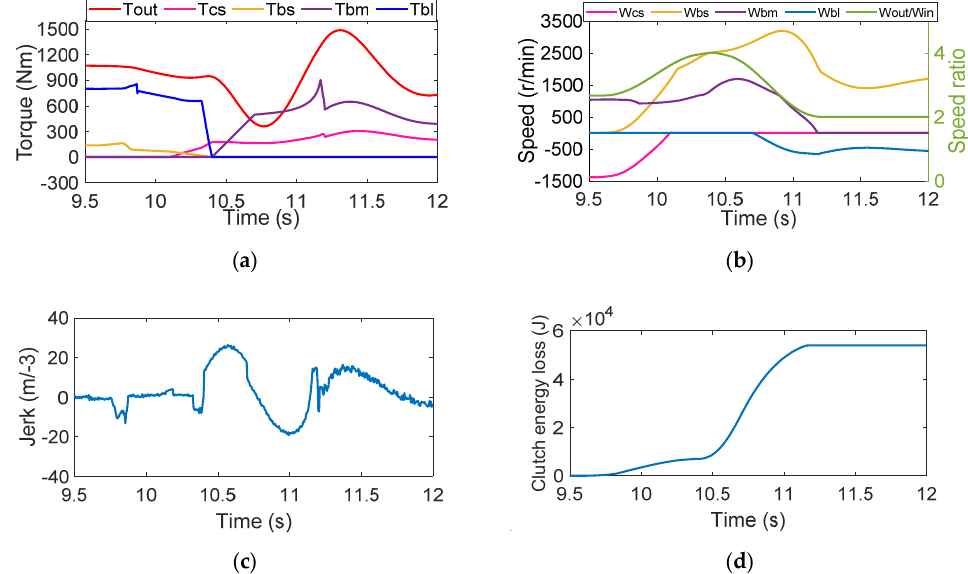
Figure 9. Simulation results of 2–3 power-on double-transition upshift for Strategy 5. ( a ) Output shaft and clutch torque. ( b ) Clutch speed and speed ratio. ( c ) The jerk of shift process. ( d ) The clutch energy loss of shift process.